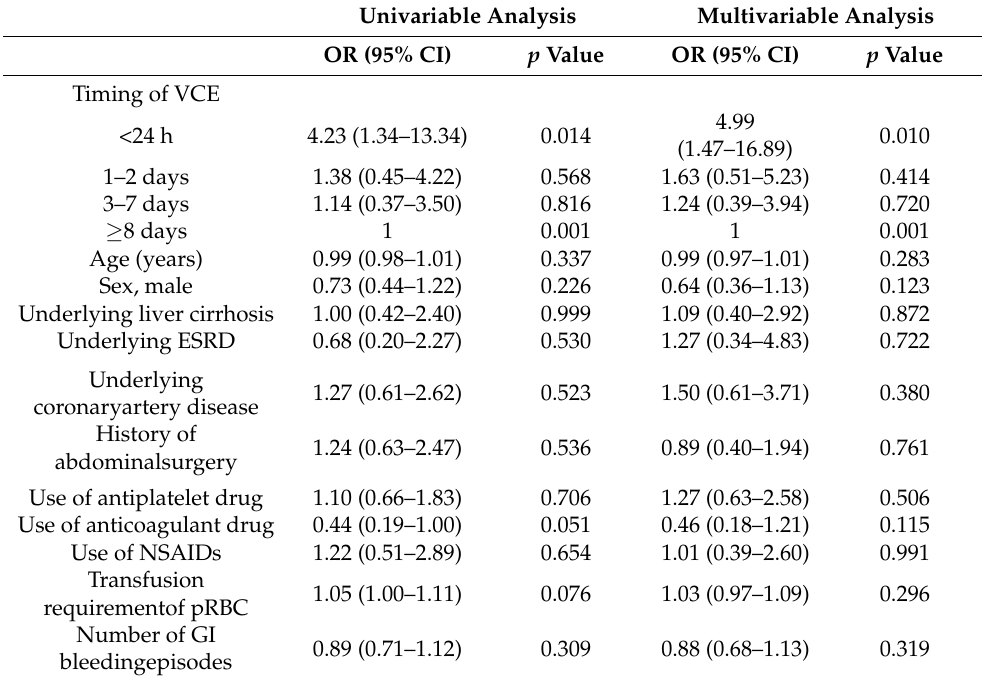
Table 4. Risk factors for P2 detected by video capsule